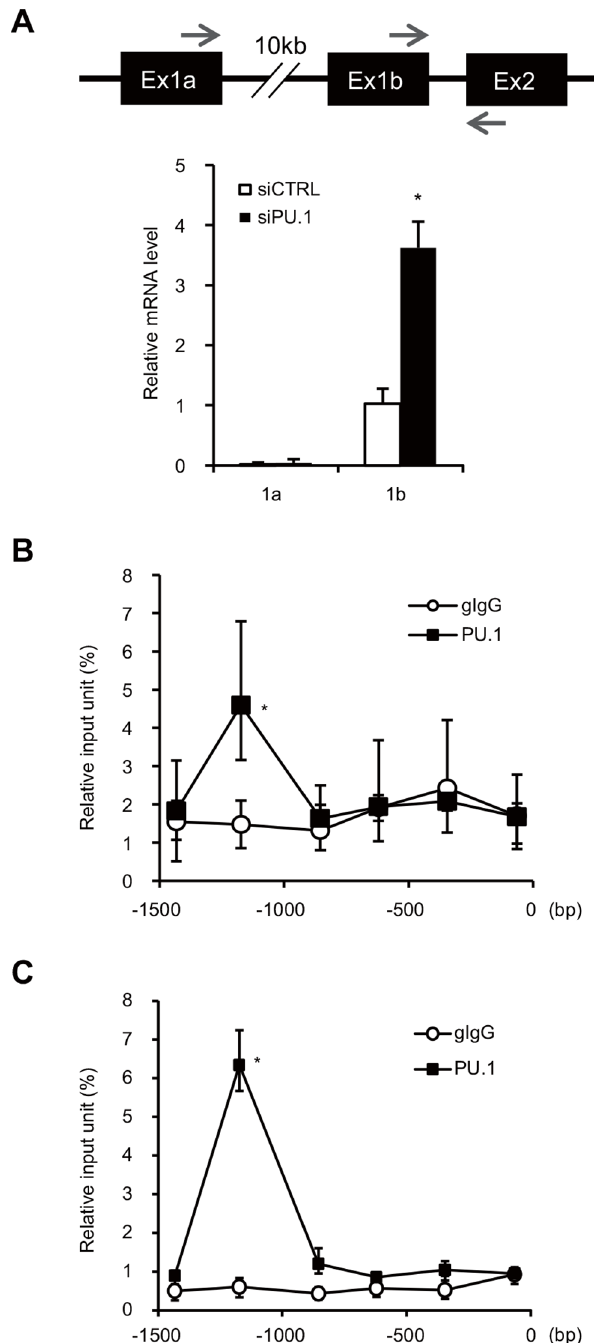
Fig 4. PU.1 binds to the Gata3-1b promoter. (A) Upper carton: Schematic drawing of the mouse Gata3 gene. Ex, exon; the arrows over exons 1a/1b and that under exon 2, indicate forward and reverse PCR primers, respectively. Lower graph: BMDCs were transfected with either control siRNA (siCTRL) or PU.1 siRNA (siPU.1). Relative mRNA levels (1a/GAPDH or 1b/GAPDH) were determined by quantitative RT-PCR after normalization to GAPDH mRNA and are expressed as the ratio of the expression level of GATA3-1b in control siRNA-introduced cells. (B, C) Quantification of PU.1 or control goat IgG binding to the Gata3-1b promoter in BMDCs (B) or in splenic DCs (C) was performed using a ChIP assay with the series of primers described in S1 Table. Binding is expressed as a percentage of the input for each ChIP assay. All results are means ± S.E.s ( n = 3). Similar results were obtained in three separate experiments. * , p < 0.05 in a two-tailed paired Student ’ s t